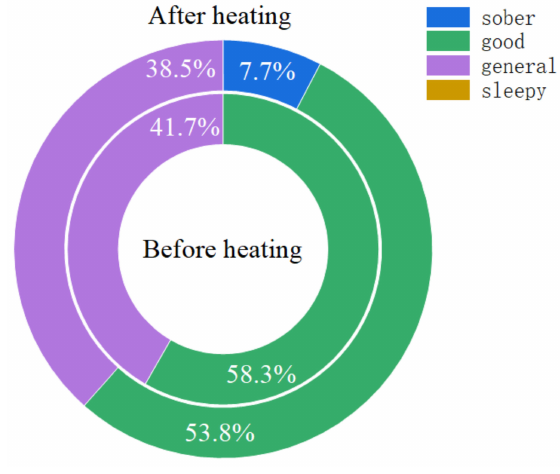
Figure 21. Mental state evaluation results.